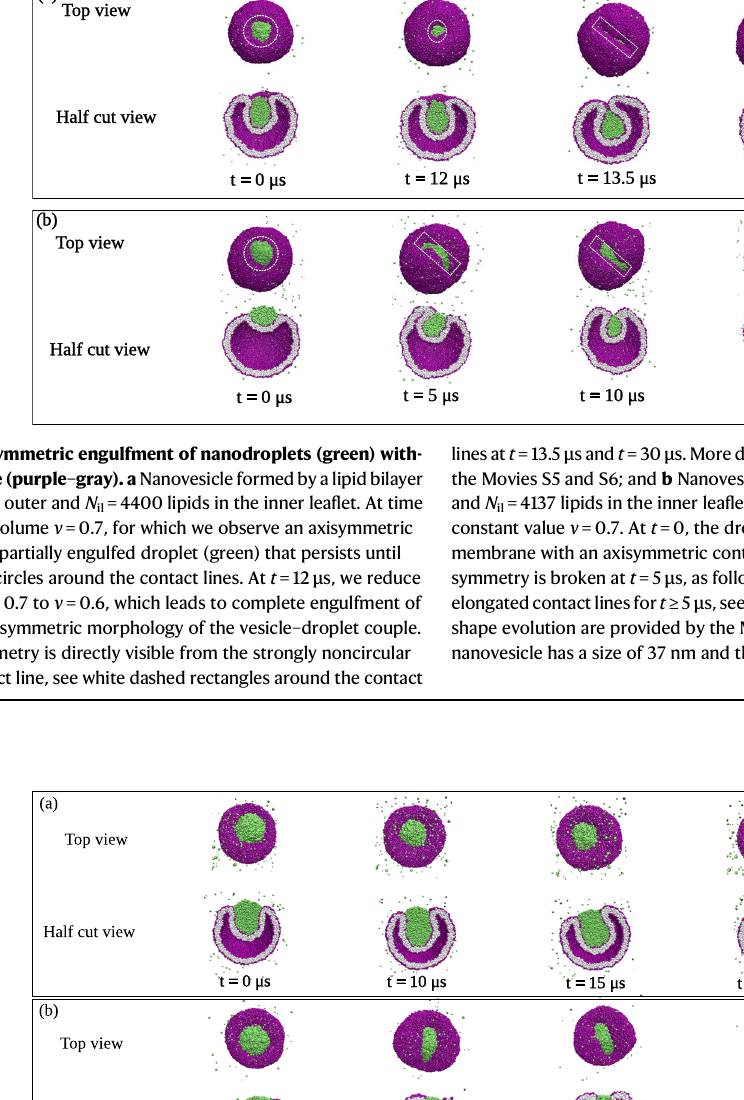
Fig.5|Partialengulfmentoflargenanodroplets(green)withadiameterof19.6 nm by vesicle membranes (purple-gray) with different transbilayer asymme- tries as controlled by the outer lipid number N ol . The large size of the droplet preventscompleteengulfment: a Nanovesiclewith N ol =5400and N il =4700aswell asvolume ν =0.45atdifferenttimepoints t .Inthiscase,thevesicle – dropletcouple maintainsitsaxisymmetricgeometryandexhibitsacircularcontactlineduringthe whole partial engulfment process. The same behavior is observed for larger